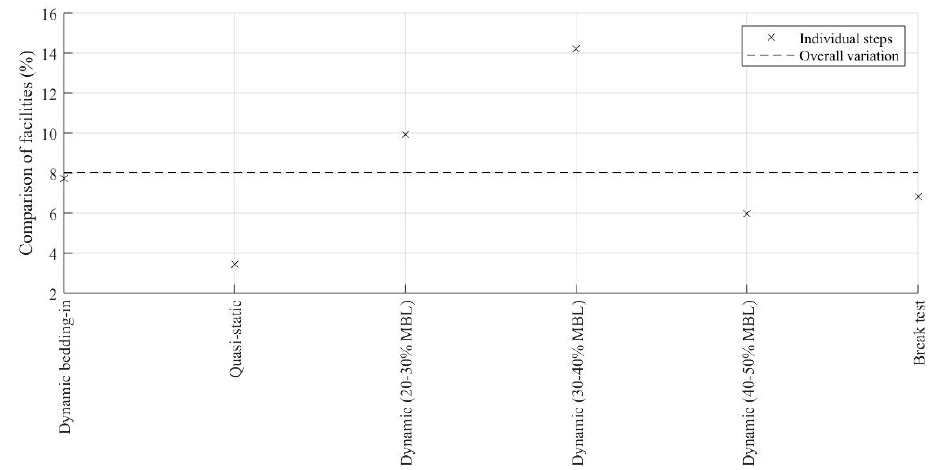
Figure 13. Comparison of the standard deviation in stiffness properties of the hybrid rope determined at DMaC and IFREMER.